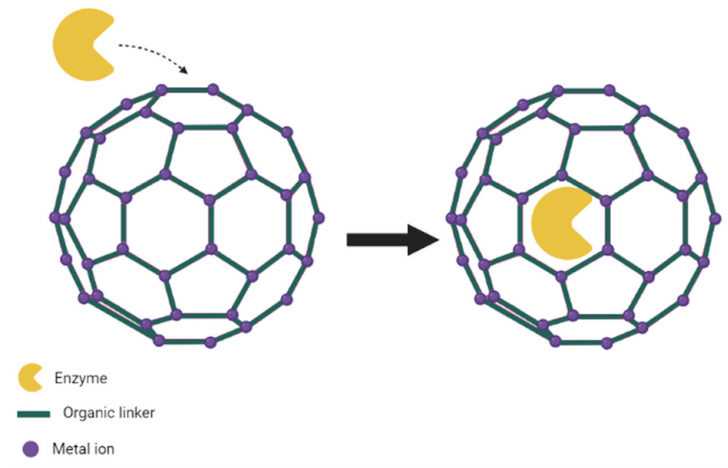
Figure 5. Schematic representation of enzyme entrapment in MOFs.